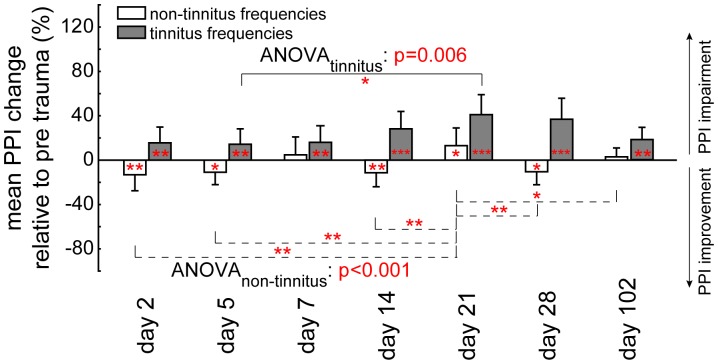
Development of tinnitus percept over time (stimulation set 2).Mean prepulse inhibition change relative to pre trauma response (in percent ± SEM) for non-tinnitus frequencies (open bars) and all tinnitus frequencies (black bars) obtained up to 102 days after trauma, exemplary in four T animals. An impairment of PPI is plotted upward, an improvement downward; significant difference of data to pre trauma is depicted by asterisks in each bar (one sample t-tests vs. 0). Connecting lines indicate significant Tukey post-hoc tests. Significance levels: * p<0.05, ** p<0.01, *** p<0.001.